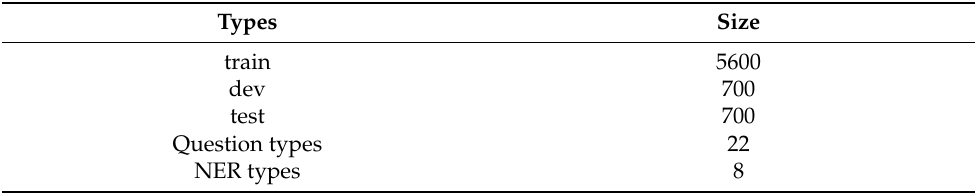
Table 2. Datasets and statistics of KQU. Types